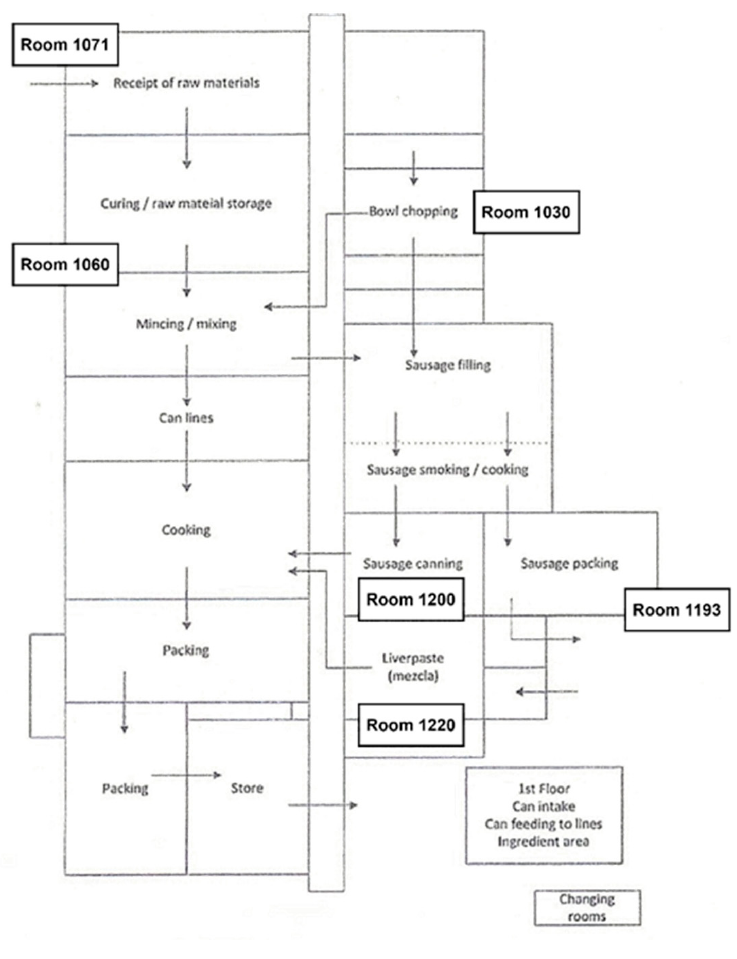
Figure 7. An overview of the case-study-facility layout.